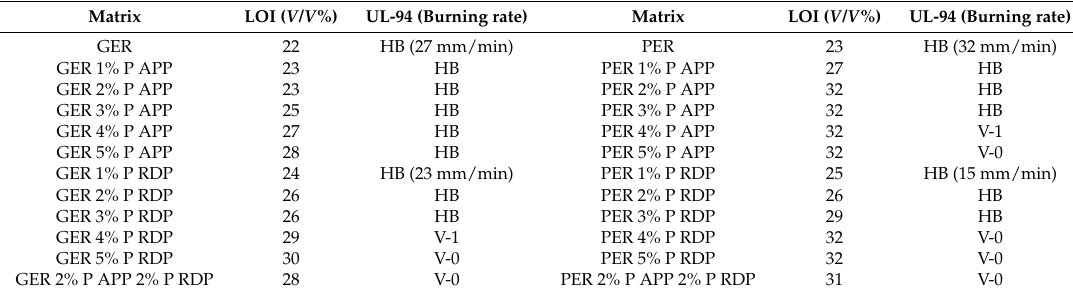
Table 1. Limiting oxygen index (LOI) and UL-94 results of the reference and flame retarded trifunctional glycerol (GER) and tetrafunctional pentaerythritol-based (PER) matrices. APP: ammonium polyphosphate; RDP: resorcinol bis(diphenyl